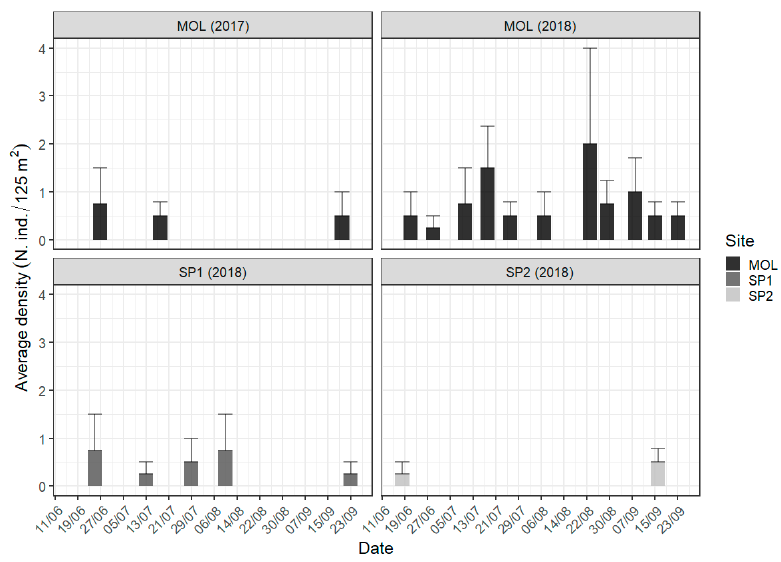
Figure 2. Average densities of M. rubra ( ± SE) recorded at MOL during the summer of 2017 and 2018, and at SP1 and SP2 in the summer of 2018. No mottled grouper was censused at SP1 and SP2 in the summer of 2017. Four replicates (strip transects) per study site per sampling date were conducted. Statistically significant differences in grouper density were found across the study sites for both years combined (Kruskal–Wallis chi-squared = 14.41, df = 2, p = 0.0007). The Dunn test found a significant difference only between MOL and the other two study sites (Figure 3, Supplementary Materials Table S1). Figure 3. Box-plot of the cumulative abundance of individuals of the mottled grouper censused per study site considering both years (2017 and 2018). Number of replicates (strip transects) per site: 88 at MOL, 64 at SP1 and 52 at SP2. Mottled grouper density was significantly different at MOL com- pared to the other sites (Kruskal–Wallis chi-squared = 14.41, df = 2, p = 0.0007).